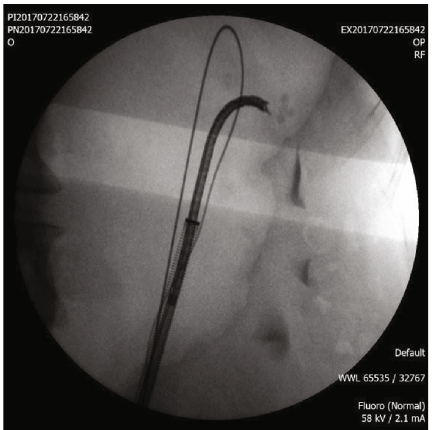
Figure 3: Pulverized calculi with the holmium